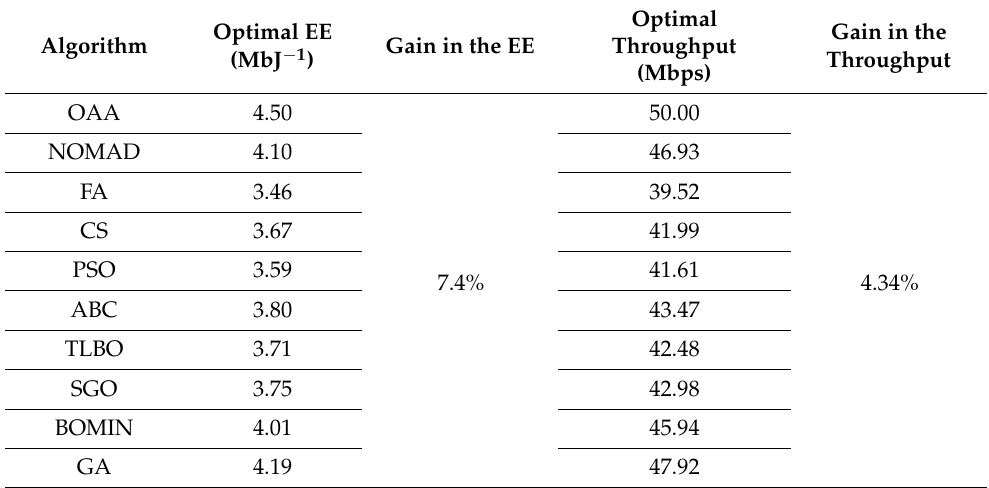
Table 5. Comparison of the optimal solution of proposed algorithm with the existing algorithms.